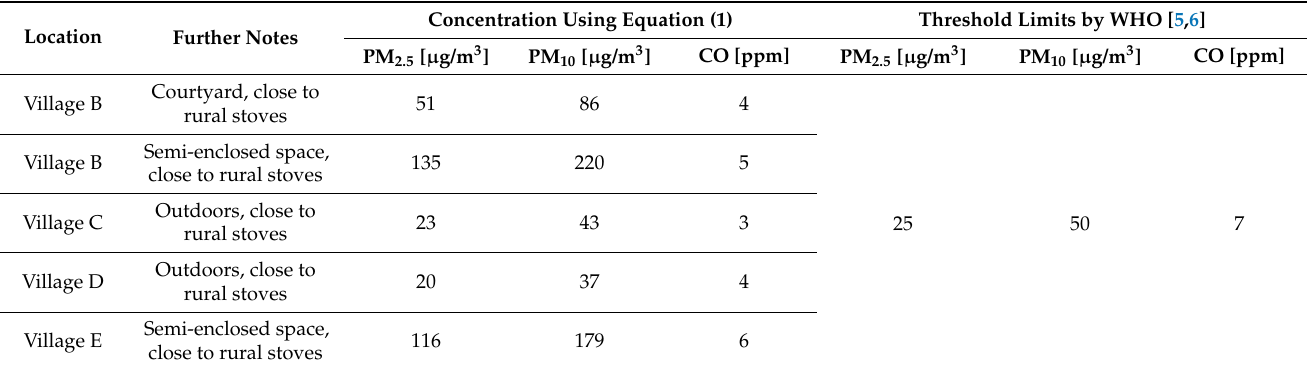
Table 3. Concentrations of PM 2.5 , PM 10 , and CO as an average in 24 h, as calculated with Equation